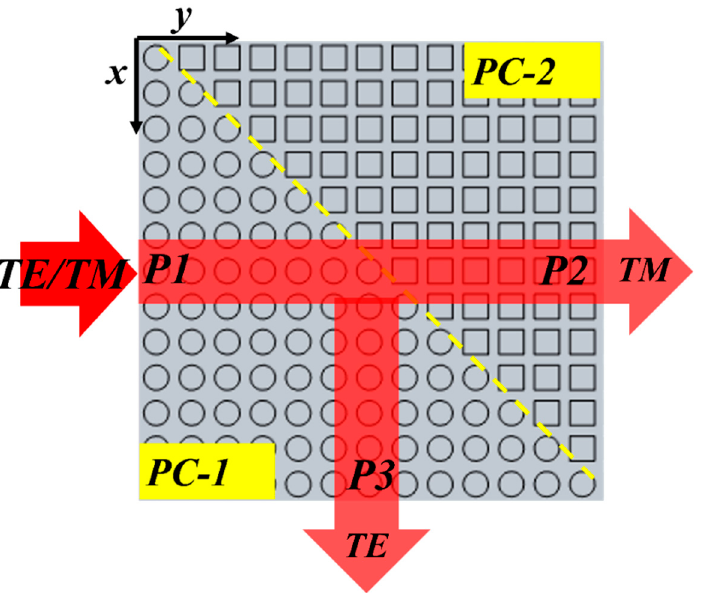
Figure 5. Graphical representation of heterostructure PC on-chip PMD.